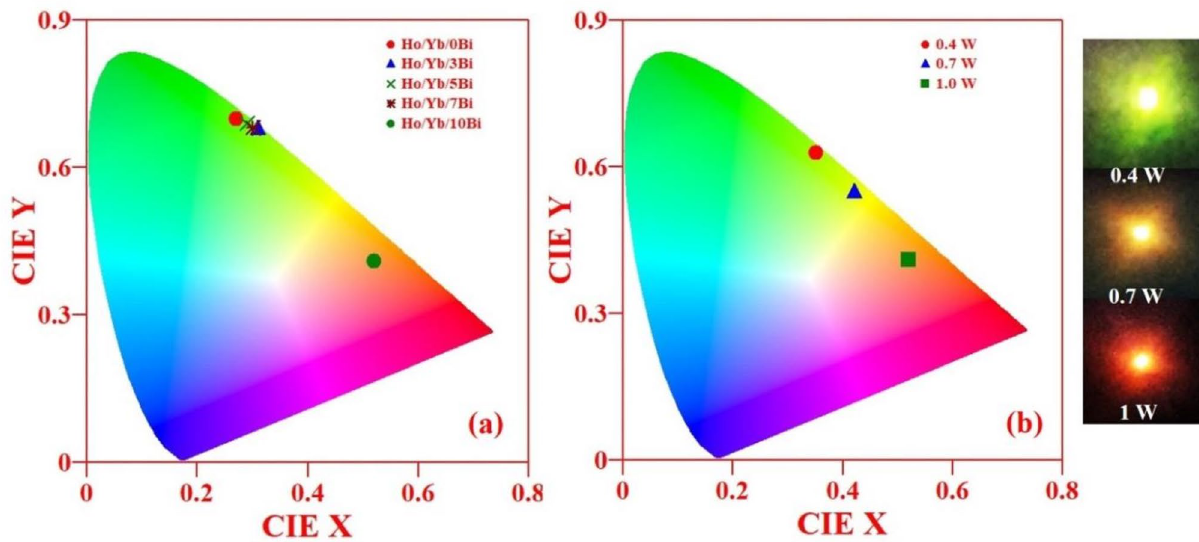
Figure 14. The CIE diagrams for ( a ) the Ho 3+ /Yb 3+ /xBi 3+ co-doped ZnGa 2 O 4 phosphor materials for various concentrations of Bi 3+ ion (i.e. x = 0, 3, 5, 7 and 10 mol%) under 980 nm excitations at 31.84 W/cm 2 and ( b ) for various power densities of 980 nm diode laser (i.e. 12.73, 22.29 and 31.84 W/cm 2 ) in the Ho 3+ /Yb 3+ /10Bi 3+ co-doped material using GoCIE 1931 software.